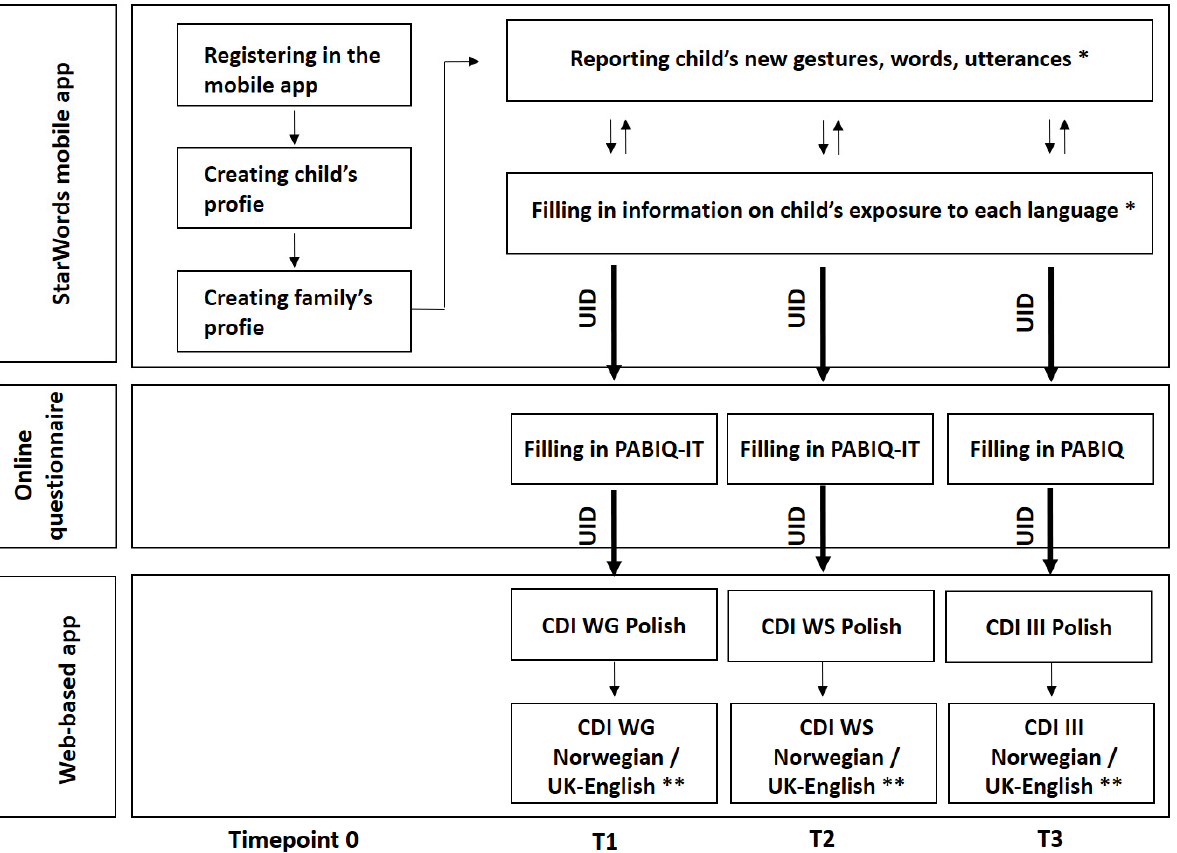
Figure 1. Study procedure. The data collected with the three tools (StarWords mobile app, online PABIQ [-IT] questionnaires and web-based CDIs) is matched via the traveling unique user identifier (UID) not overtly known to the participant (see Section 3.4.4). Note. * continuous data collection (see Section 3.4.1). ** Language dependent on the type of bilingual group (Polish-Norwegian or Polish-British English). Polish monolinguals receive CDIs in Polish only (see Section 3.4.3).